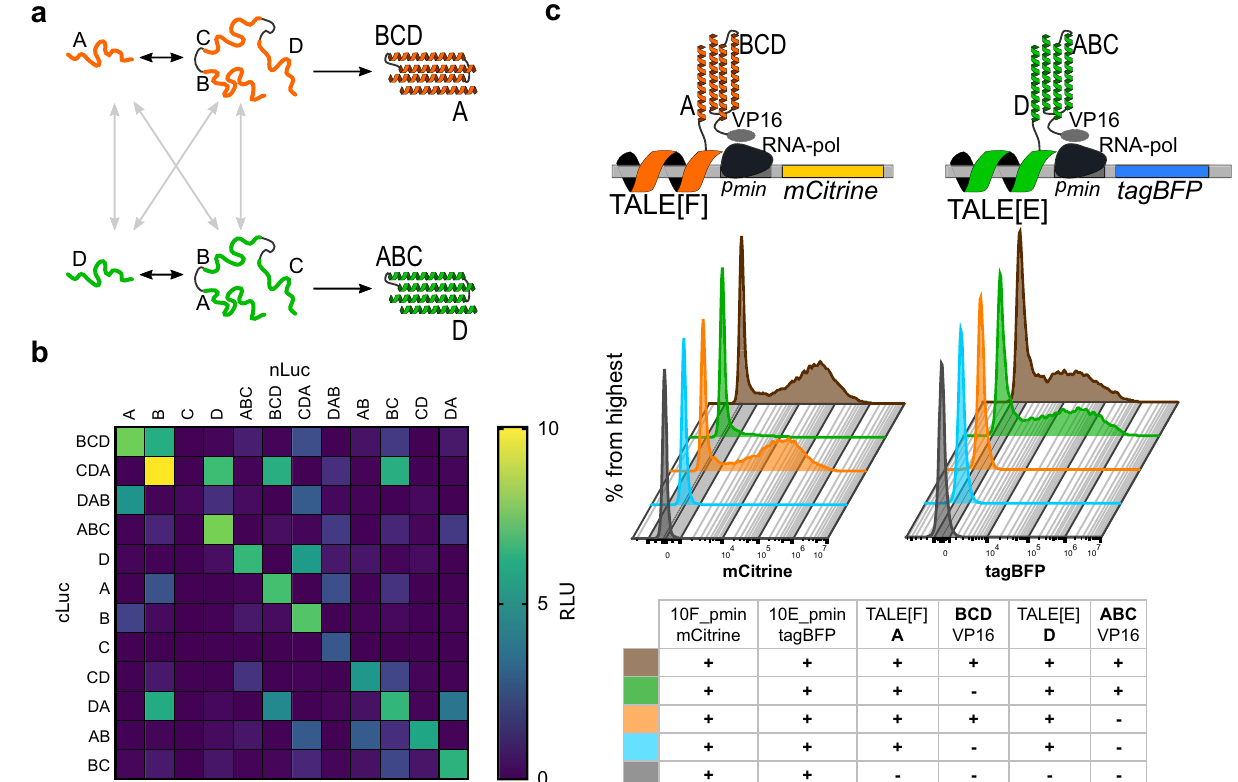
Fig. 3 | Orthogonality of 2:2 and 1:3 segmented 4HB dimerization modules in HEK293T cells. a Schematic of orthogonality experiment design. Two 1:3 seg- mentations interact with their designed partner (black arrows), successfully forming a 4HB; interactions between modules from different segmentations are notdesired(grayarrows). b Orthogonalityofthedesigned2:2and1:3dimerization domains. HEK293T cells were transiently transfected with 25ng of the